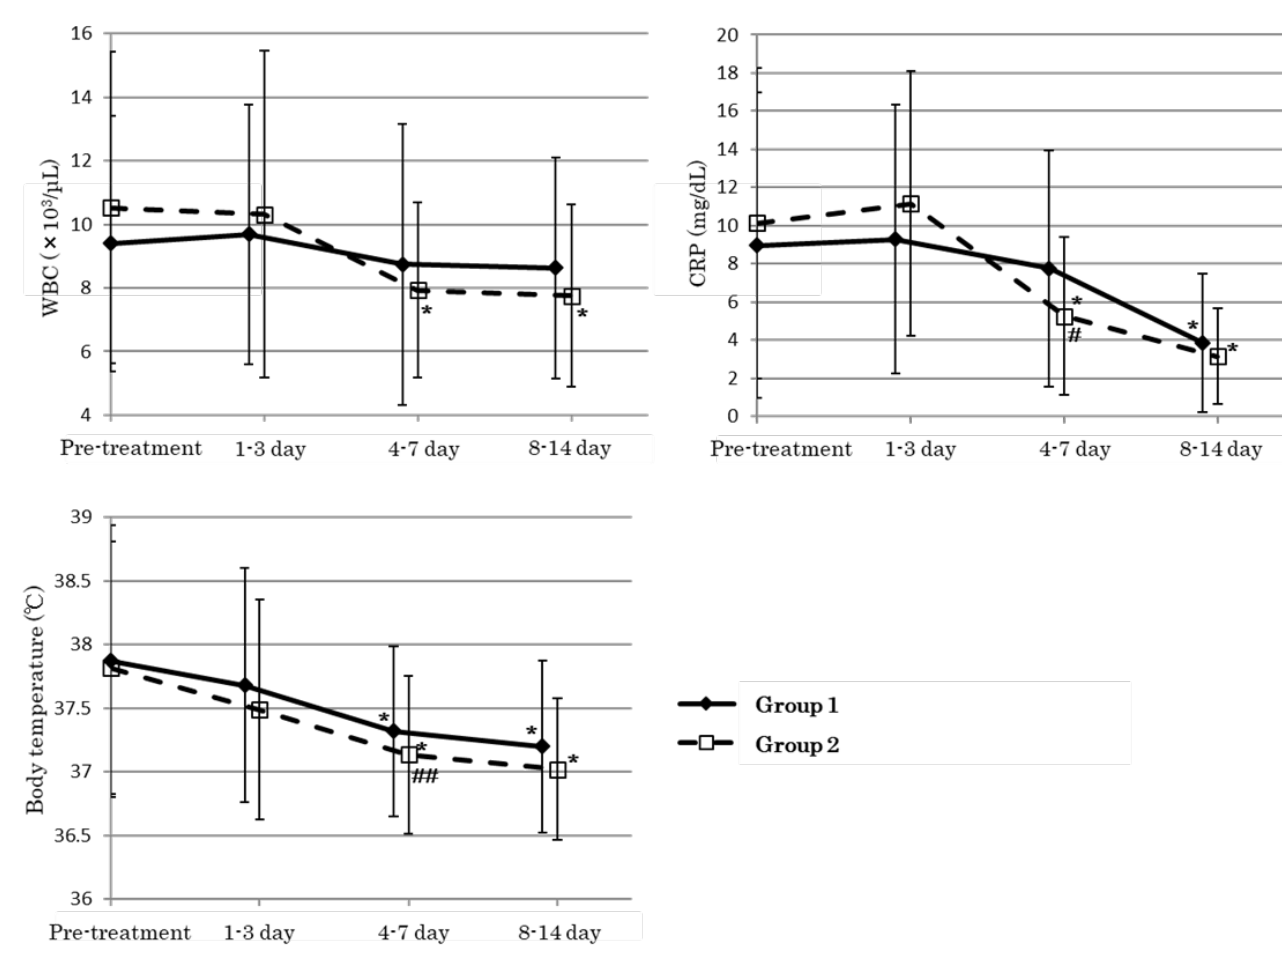
Figure 1. Time-dependent changes in WBC, CRP, and body temperature during and after initiation of ceftriaxone therapy. Data are presented as the mean ± SD. *: p < 0.05 (vs. pre-treatment: Dunnett’s test); #: p < 0.05 (vs. group 1: unpaired t-test); ##: p = 0.0523 (vs. group 1: unpaired t-test). Group 1, n = 33; group 2, n = 28. CRP, c-reactive protein; SD, standard deviation; WBC, white blood cell.